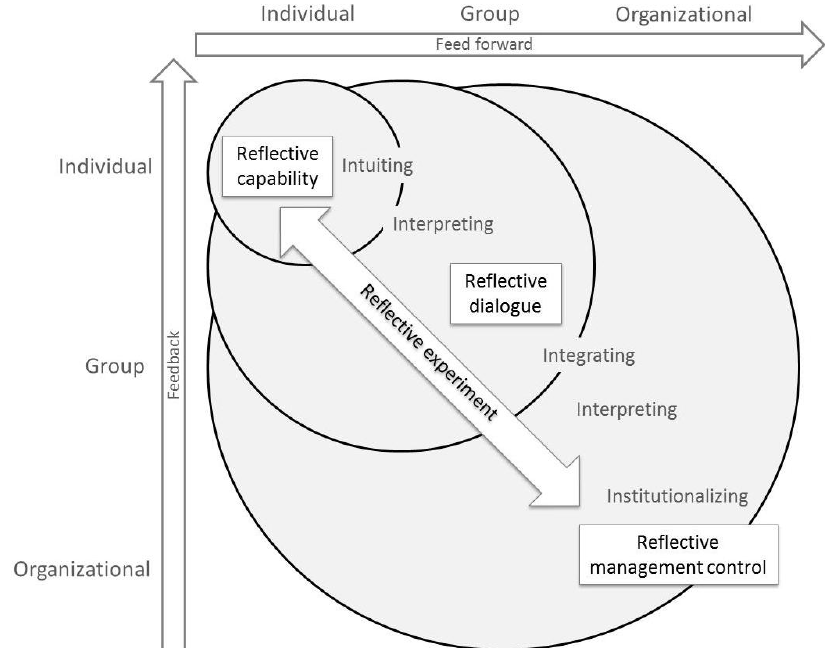
Figure 1. Reflective practice enabling 4I learning processes (based on Crossan et al.